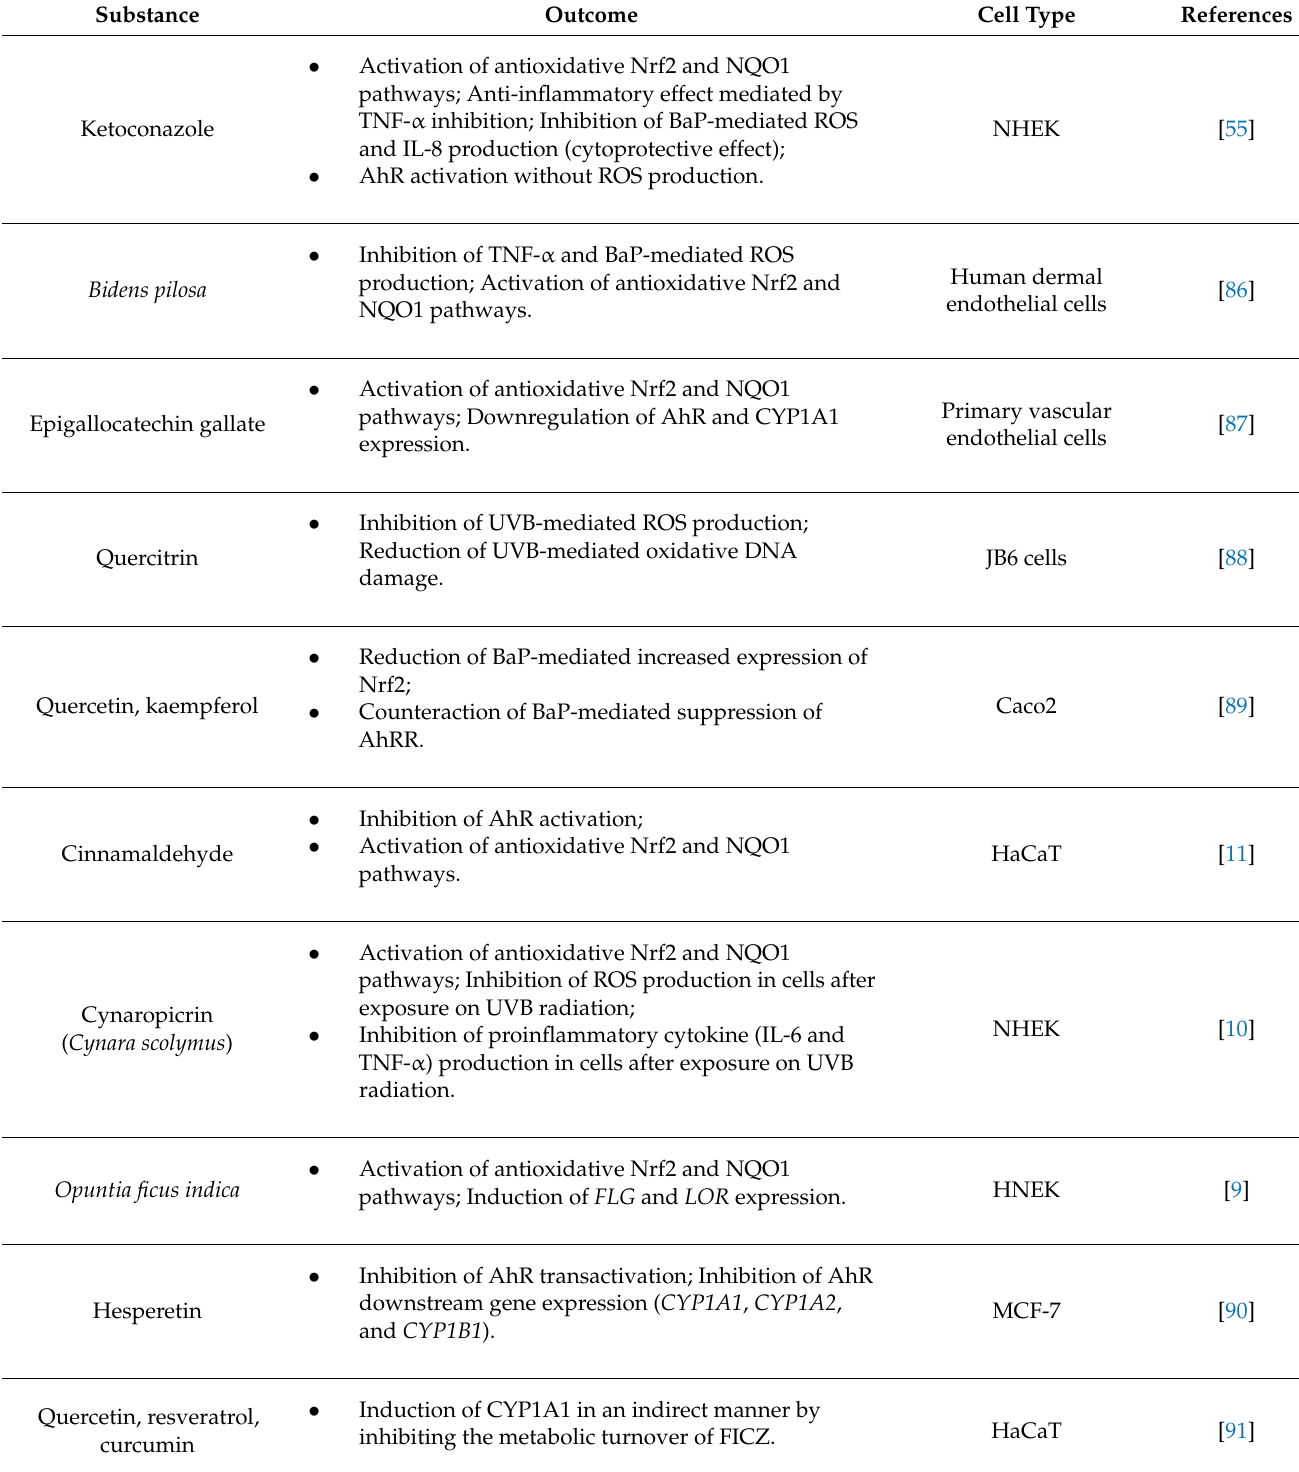
Table 2. The AhR signaling pathway mediates antioxidative signals in response to different substances, e.g., herbal medicines and